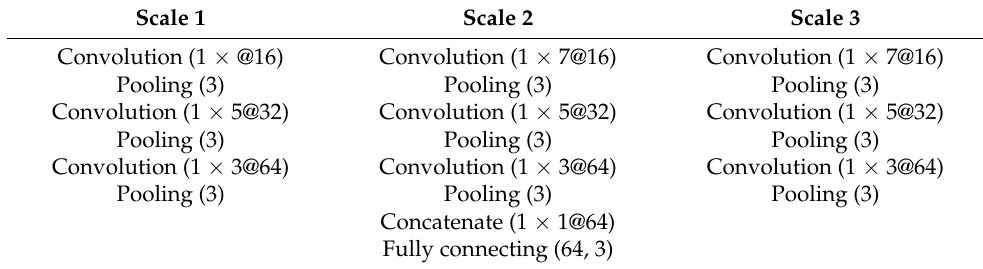
Table 3. Parameters of the